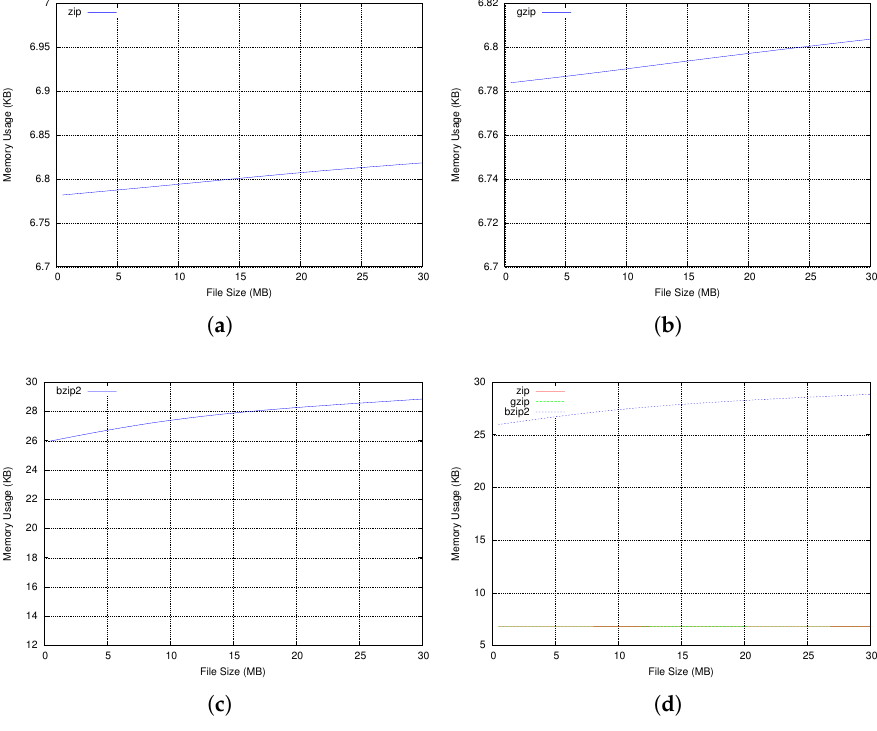
Figure 9. Memory usage by SH-VARR snapshot based on three compression algorithms. ( a ) Using zip algorithm; ( b ) Using gzip algorithm; ( c ) Using bzip2 algorithm; ( d ) All